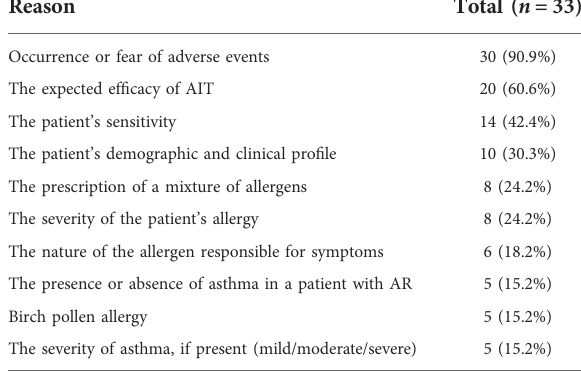
TABLE 2 The physicians ’ stated reasons for adjusting the dose of